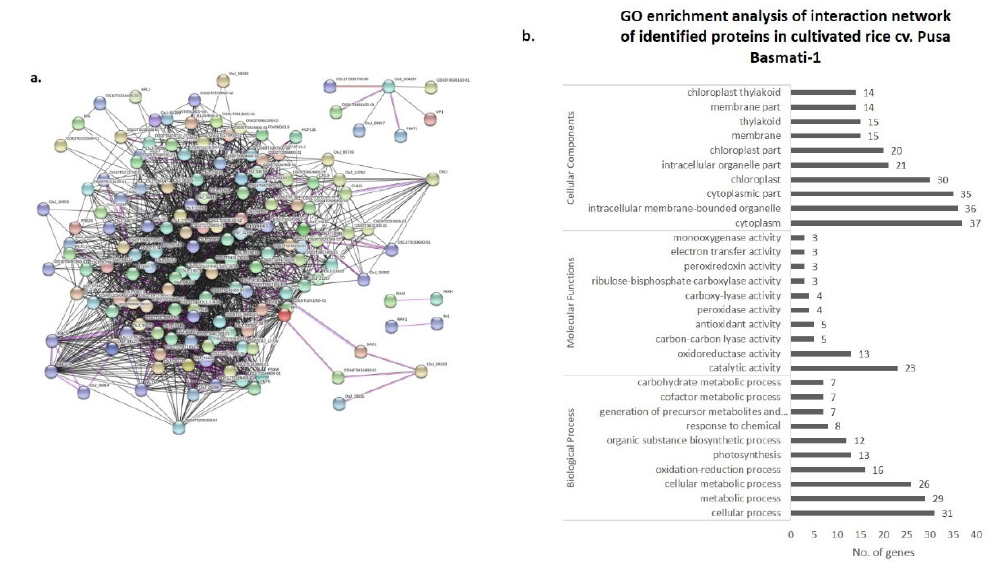
Figure 6. ( a , b ). Protein interaction network analysis of differentially expressed proteins (including primary interactors) in cultivated rice cv. Pusa Basmati-1 using STRING v.11.0. ( a ) Network was constructed at an interaction score cut off value of ≥ 0.700 with maximum number of primary interactors set to 500, including experimental evidence (pink lines), gene fusion (red lines), and co‐expression (black lines). ( b ) Graph showing GO enrichment analysis of interaction network representing the no. of genes classified in respective GO categories (FDR corrected p value ≤ 0.01).